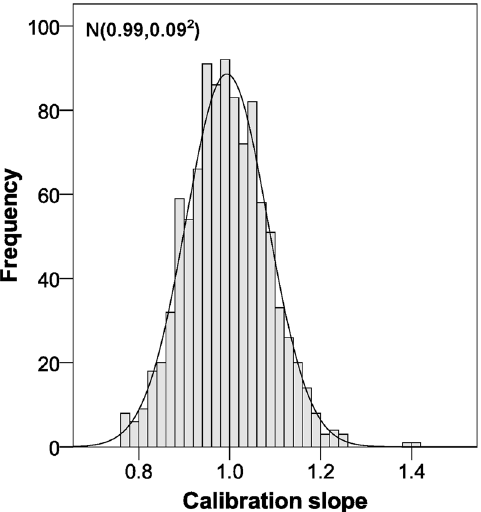
Figure 3. Calibration slope distribution for the validation of our scoring system using the bootstrap method.